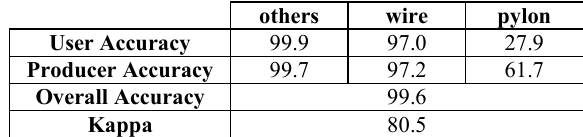
Figure 5. Visualization of obstacles within a 10-meter radius with a status